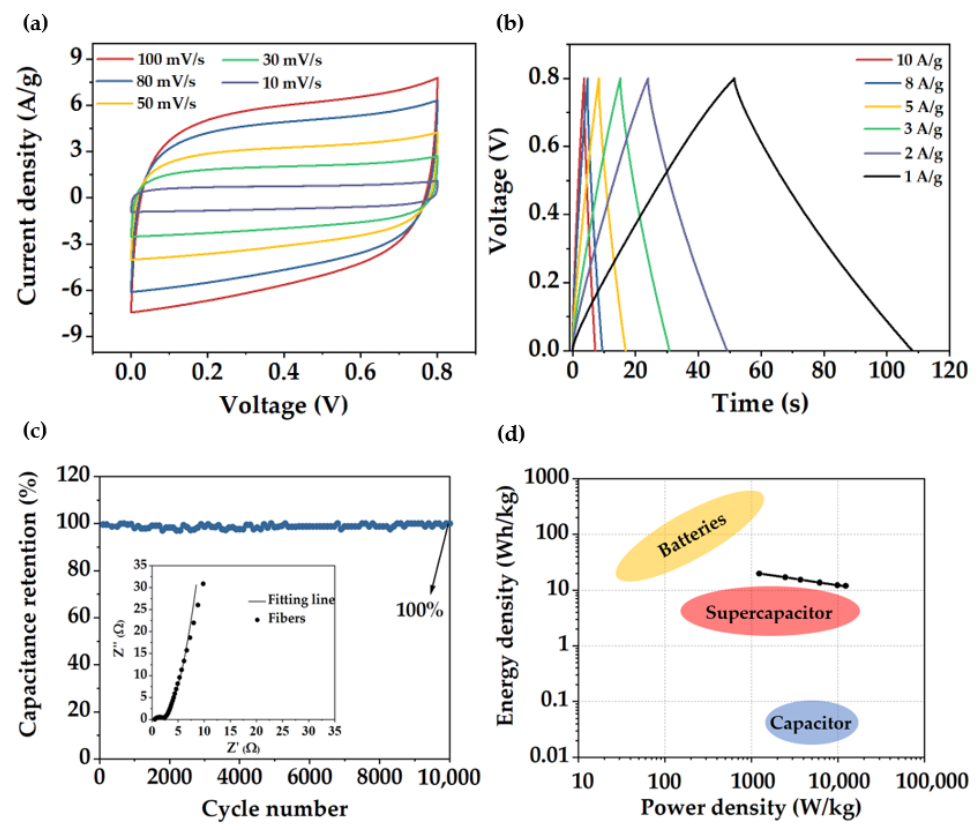
Figure 6. ( a ) CV curves at different sweep rates, ( b ) GCD curves at various current densities, ( c ) Electrode stability along 10,000 cycles at a current density of 100 A/g . Inset: EIS diagram, ( d ) Ragone ( c ) Electrode stability along 10,000 cycles at a current density of 100 A/g. Inset: EIS diagram, plot of the porous carbon fibers. ( d ) Ragone plot of the porous carbon